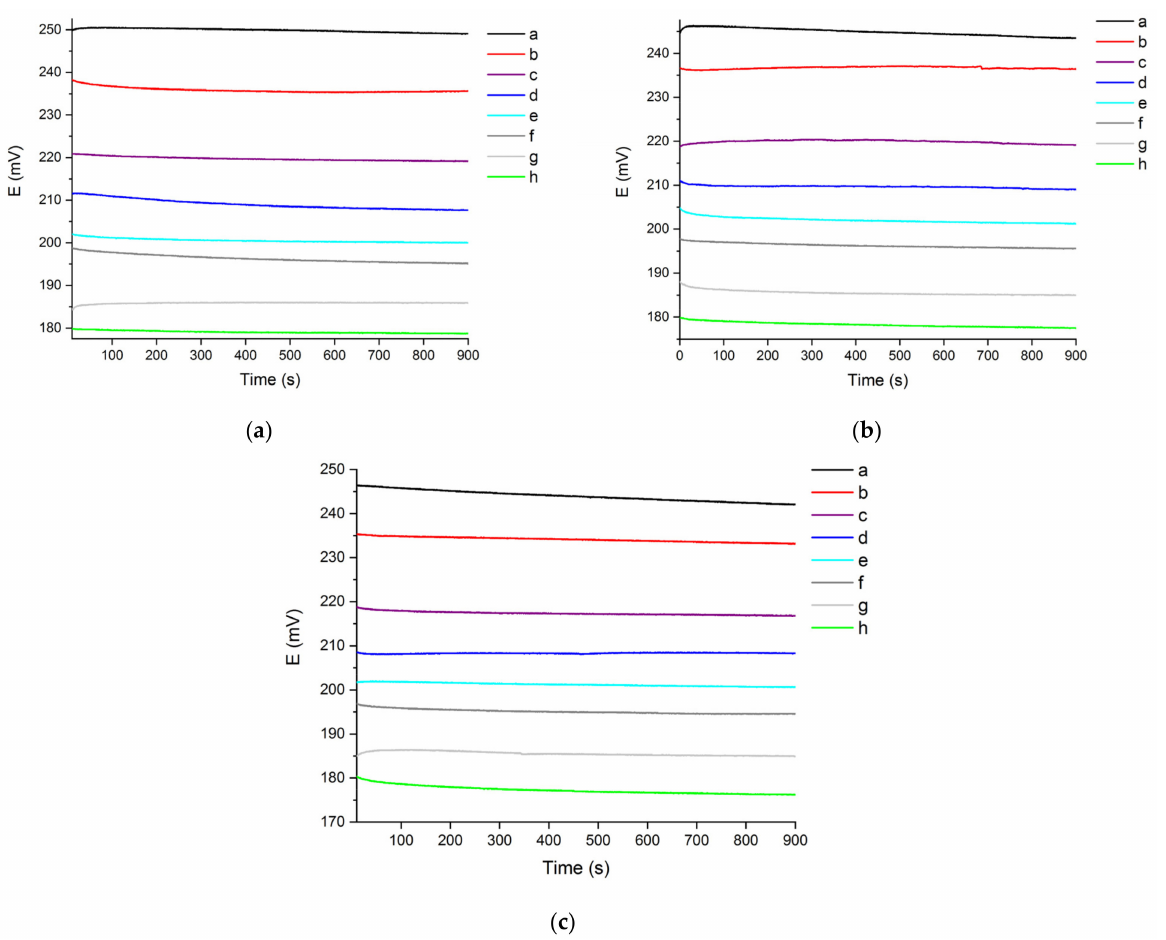
Figure 2. Chloride sensor’s OCP signal recorded in 900 s, in ( a ) 20 ◦ fH, ( b ) 30 ◦ fH and ( c ) 40 ◦ fH solutions with different chloride content (a: 5 mg/L; b: 10 mg/L; c: 20 mg/L; d: 30 mg/L; e: 40 mg/L; f: 50 mg/L; g: 75 mg/L; h: 100